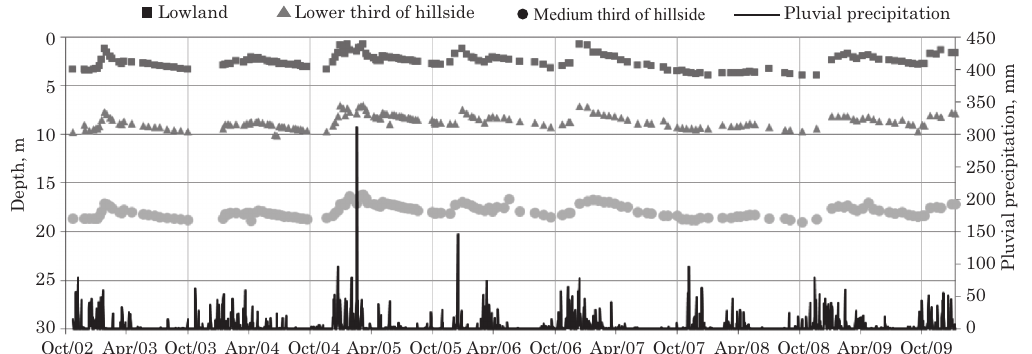
Figure 2. Depth of the water table of points monitored in three topographical positions: lowland (area of high incidence of ESBVRD); lower third of hillside (area of medium incidence), and middle third of the hillside (area of low incidence of the blight) (during the period from October 2002 to December 2009) and rainfall over this period. Planting of eucalyptus in the monitored area was carried out in October 2001 and cutting of the area in July